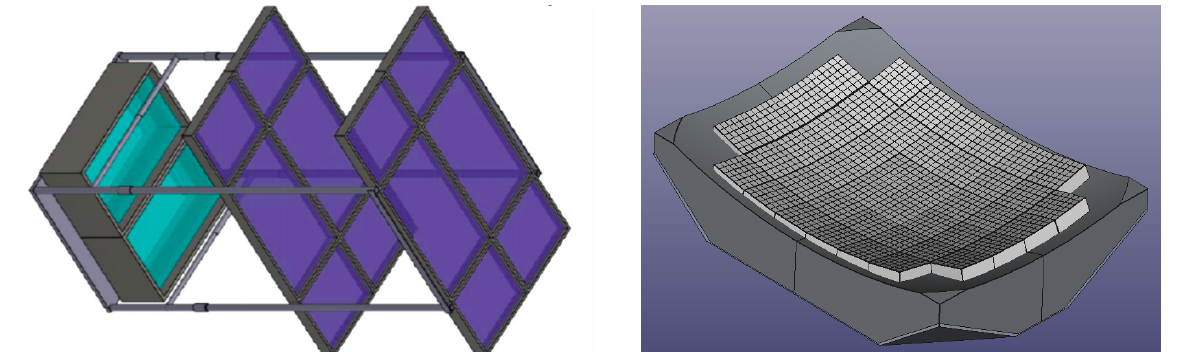
Figure 1. ( Left ): a scheme of the K-EUSO detector with segmented refractive optics and rectangular aperture as designed by GP Advanced Project company. ( Right ): a 3D model of the K-EUSO focal surface built from 44 photo detector modules. It is to be placed inside the green “box” shown in the left